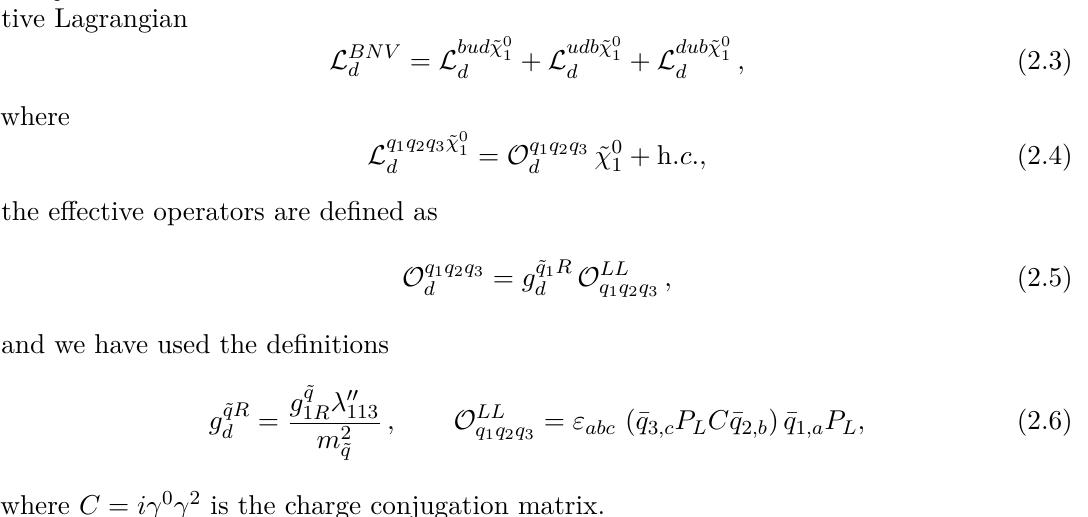
and λ 00 the corresponding RPV coupling: p, n (for λ 00 ij 3 ); and Ξ + , Ξ 0 (for λ 00 λ 00 c c 213 223